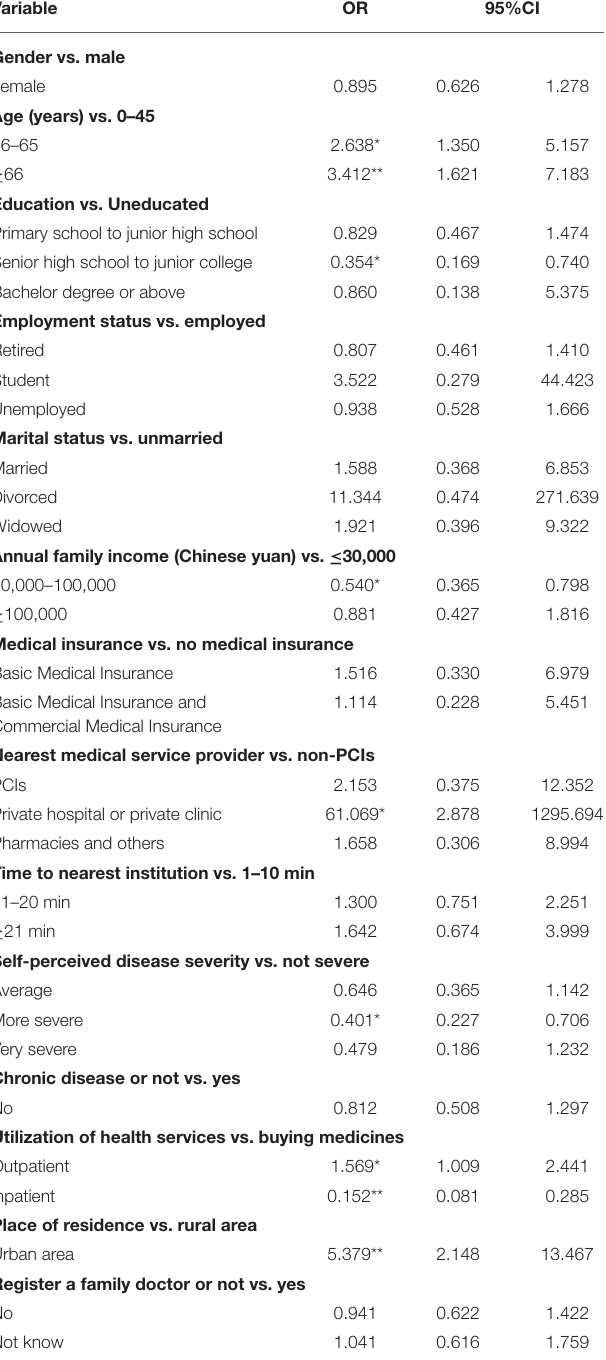
TABLE 4 | First-contact choice and first-contact willingness. First-contact willingness